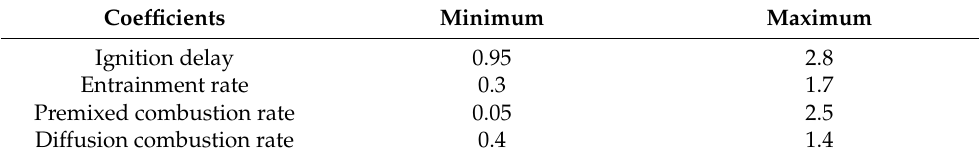
Table 3. Recommended ranges of the DIPulse model